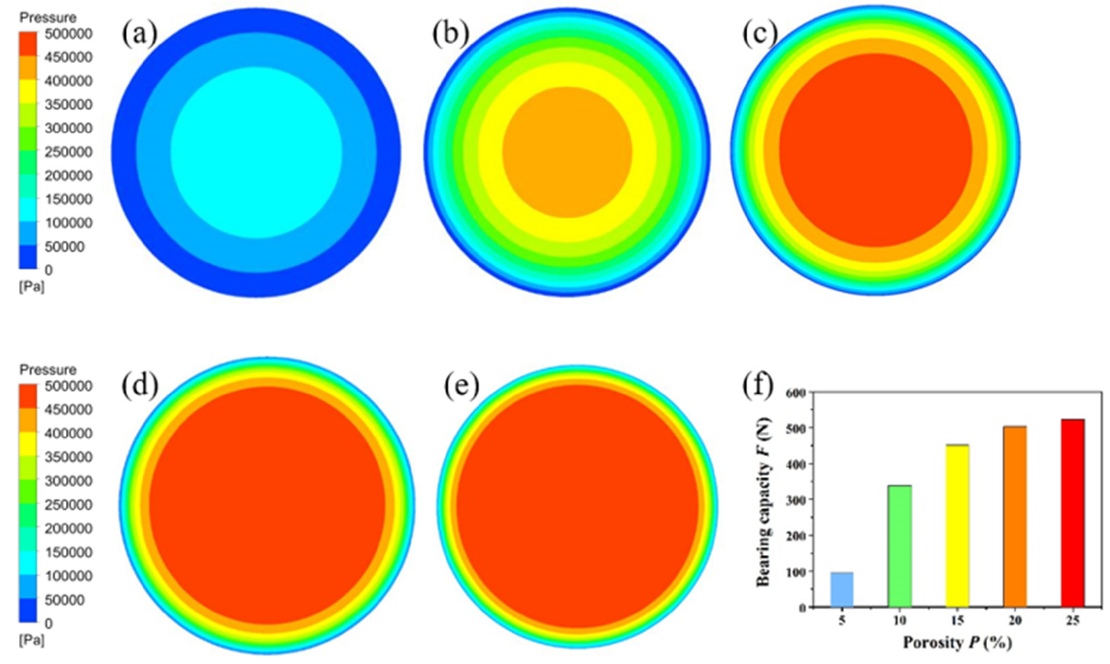
Figure 4. Gas pressure distribution on the bearing surface at different porosity: ( a ) 5%, ( b ) 10%, ( c ) 15%, ( d ) 20%, ( e ) 25% and ( f ) the relationship between bearing capacity and porosity.